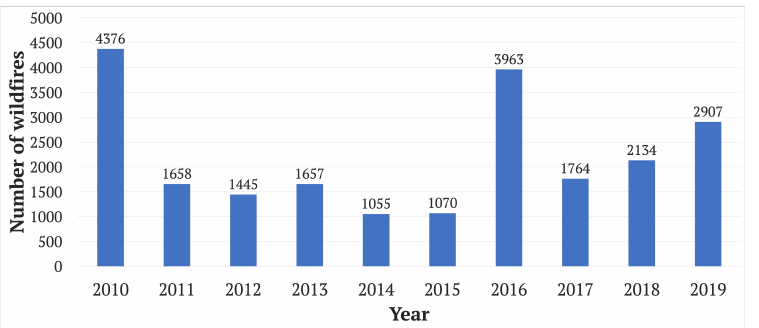
Figure 2. Number of wildfires in the department of Santa Cruz (Bolivia) from 2010 to 2019.